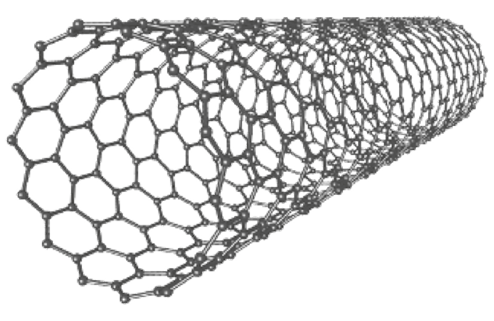
Figure 3: Structure of single wall carbon nanotube